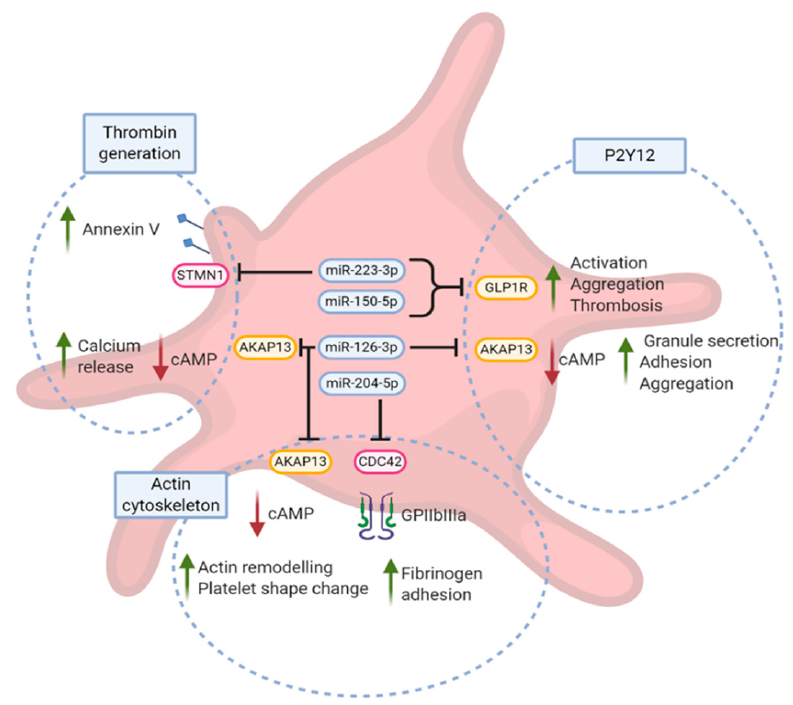
Figure 3. Putative associations between miRNAs and platelet function. The predicted target genes of candidate miRNAs were matched against GO-pathway genes (open circles) involved in platelet function (P2Y12, thrombin generation and actin cytoskeleton). Red boxes: experimentally validated gene targets; yellow boxes: in silico-predicted gene targets.